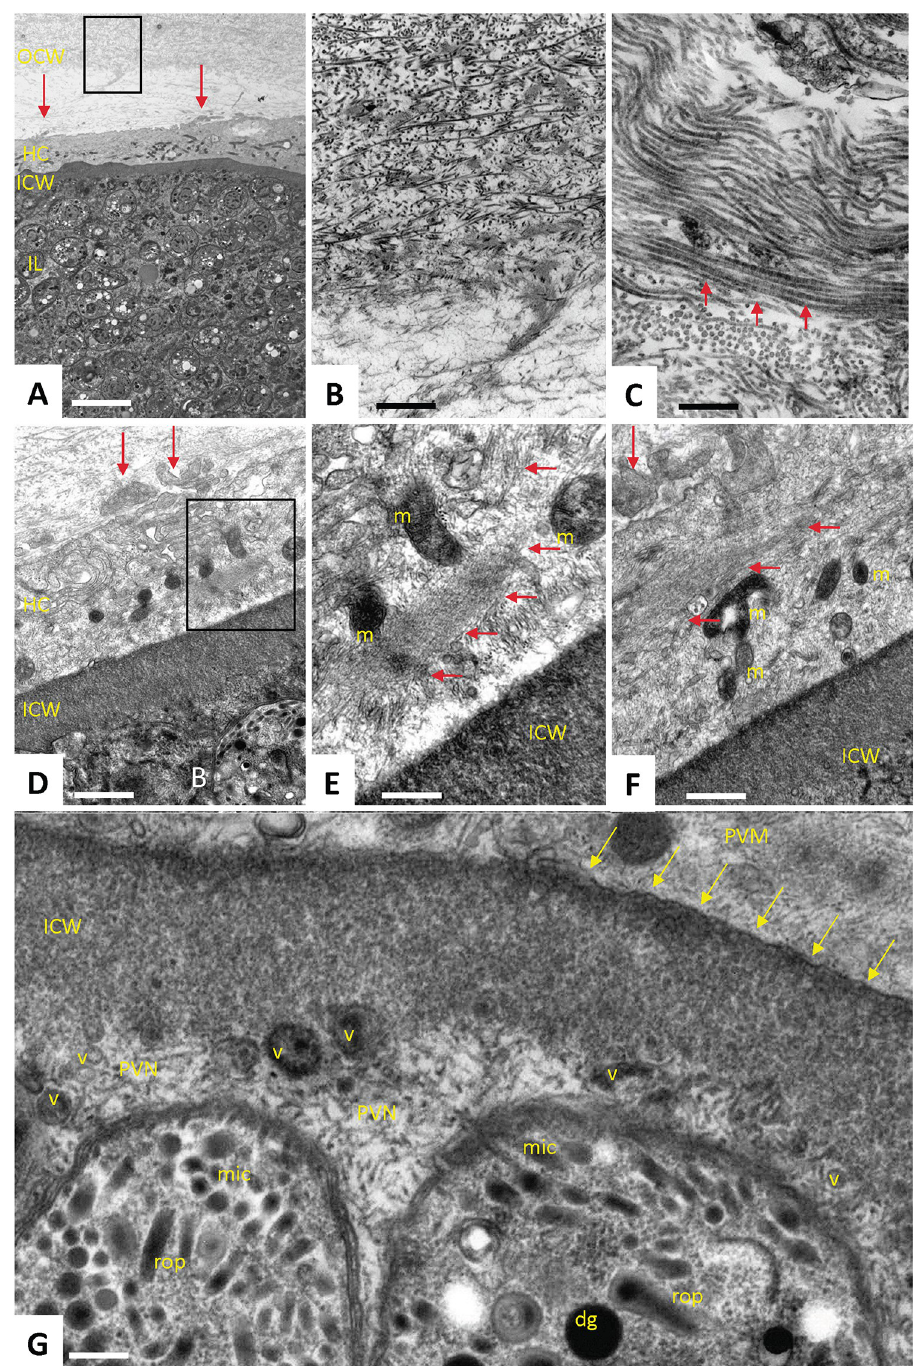
Fig 2. Transmission electron microscopy of tissue cysts. (A-C) Compartments of the tissue cyst, with the fibrous outer cyst wall (OCW), host cell cytoplasm (HC), inner cyst wall (ICW) and the inner lumen of the tissue cyst (IL). Red arrows indicate peripheral cytoplasmic host cell-extensions into the OCW. The boxed area in (A) is magnified in (B) , showing that the OCW is composed largely of fibrous material, and in (C) an even higher magnification depicts the collagen-like filament bundles (red arrows). (D) Host cell cytoplasm with cytoplasmic extensions (vertical red arrows) and inner cyst wall. The boxed area in (D) is enlarged in (E). (E-F) Larger magnification of the host cell cytoplasm adjacent to the inner cyst wall, with the presence of numerous electron-dense mitochondria (m) and many cytoskeletal filament bundles (horizontal red arrows). (G) Higher magnification view of the parasite-host cell interface, showing the ICW and its electron-dense granular substance, the parasitophorous vacuole membrane (pvm, yellow